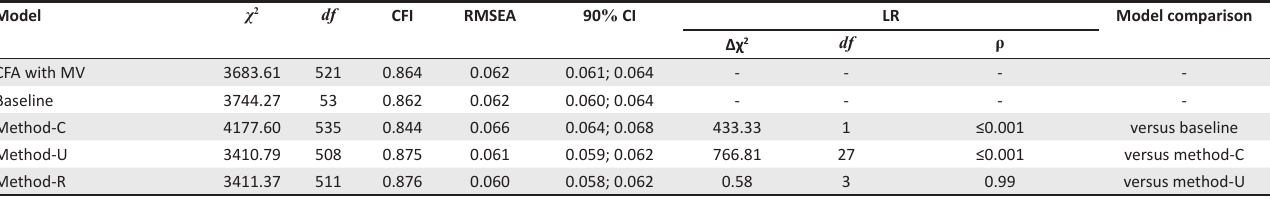
TABLE 7: Model fit indices and model comparisons for CFA models with marker variable (social desirability). Model Model